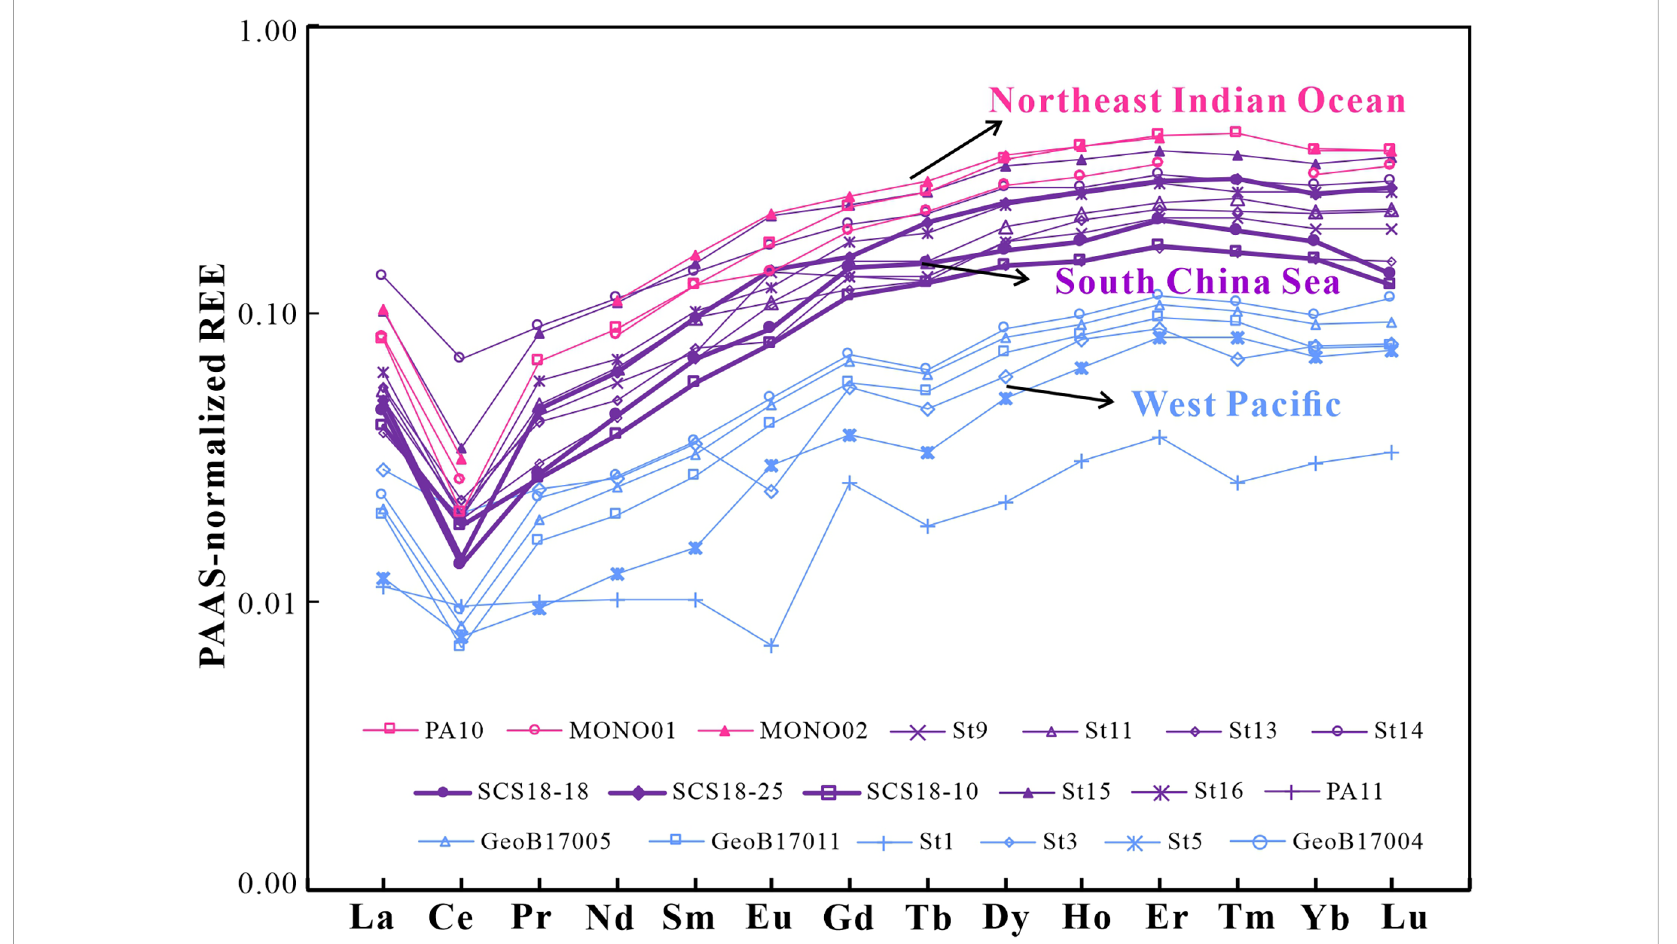
FIGURE 4 PAAS-normalized REE patterns of surface water in the SCS (this study; Alibo and Nozaki, 2000; Wu et al., 2015), the West Paci fi c (Wu et al., 2015; Behrens et al., 2018a), and the northeast Indian Ocean (Nozaki and Alibo, 2003; Yu et al., 2017). The locations of stations studied by Alibo and Nozaki (2000); Wu et al. (2015) and Behrens et al. (2018a) are shown in Figure 1. Stations PA10, MONO01, and MONO02 from the northeast Indian Ocean are located at 8° N, 89° E; 8° N, 89.4° E; and 11.8° N, 88.7° E, respectively (Nozaki and Alibo, 2003; Yu et al.,